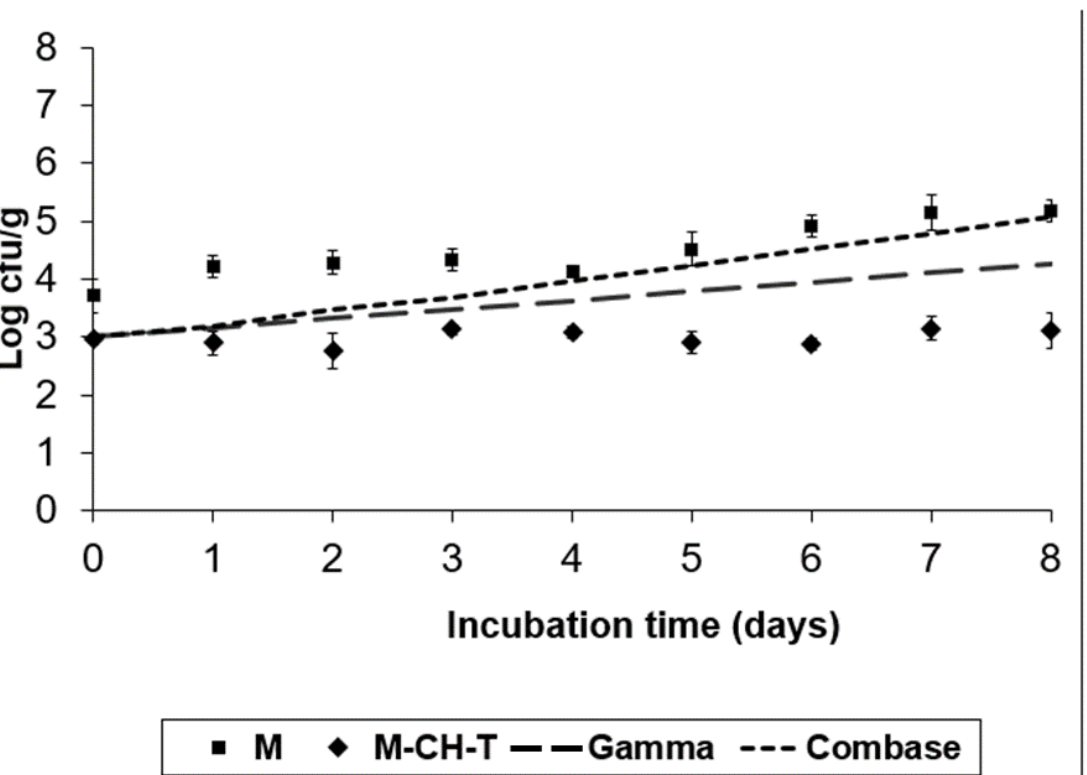
Figure 1. Growth of L. monocytogenes on the RTC product stored at 4 ◦ C, under MAP (M; (cid:4) ), under MAP with Chitosan/Thyme oil (M-CH-T; (cid:7) ) using the Gamma prediction model (— —) and the Combase ® model (- - -). M denotes RTC product, stored under MAP and M-CH-T a product stored under MAP, treated with Chitosan and